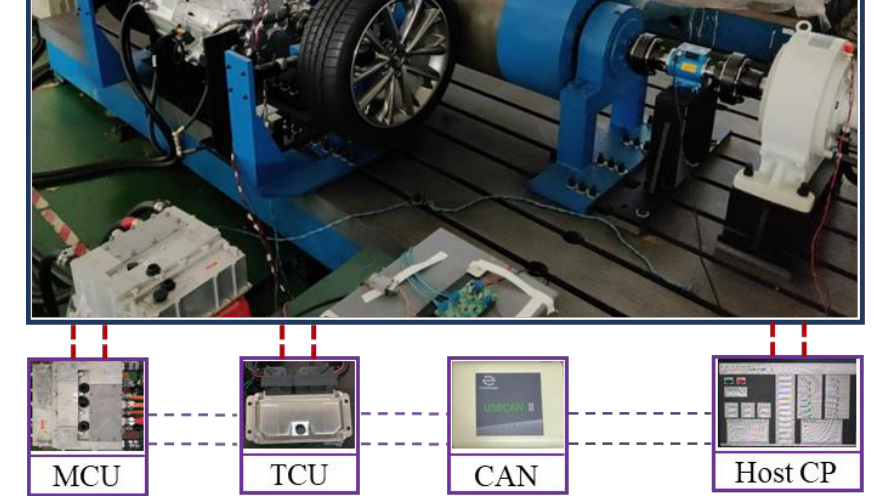
Figure 18. Testing rig.